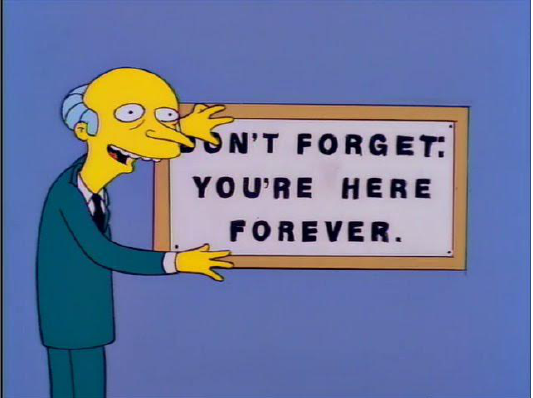
Fig. 2. JPEG image of Mr. Burns stored (without any burns) in a single transaction on 5 April 2017 using the Data Drop w/ Sig method (multiple P2SH inputs with a Redeem Script of OP_DROPs). Size: 34,600 bytes.